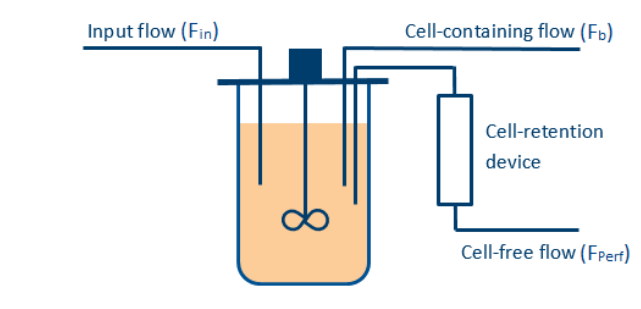
Figure 1. Simple representation of the reactor operated in perfusion mode.